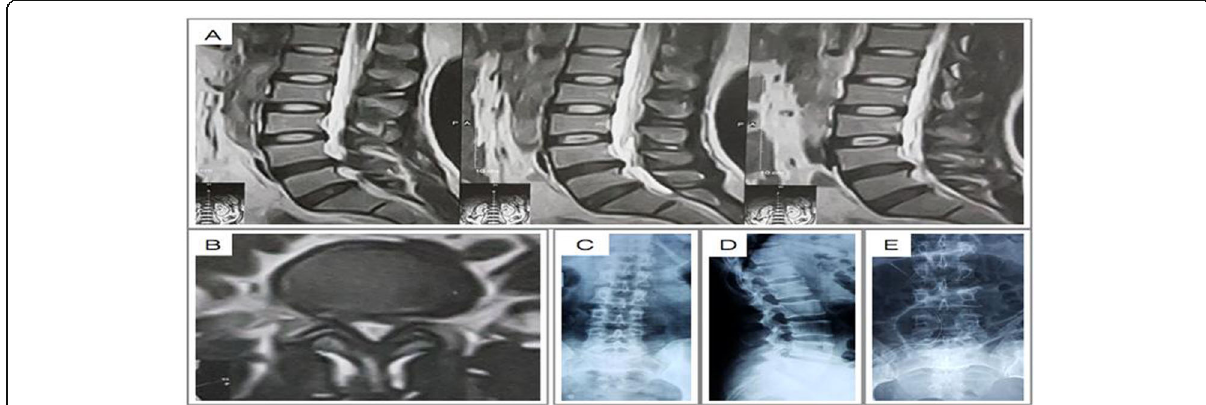
Fig. 2 Sagittal and axial T2WI MRI images ( a and b ) showed single level discogenic stenosis. Preoperative radiographs [AP and lateral views] are